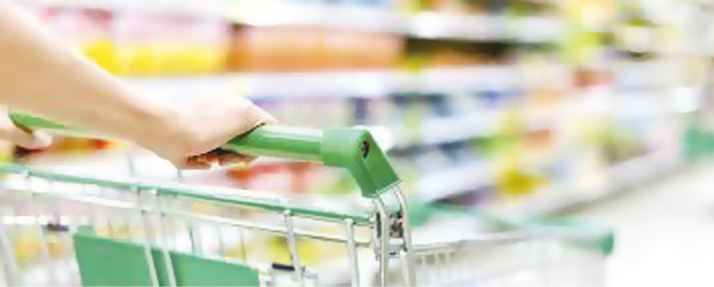
(b) Source: Plukon